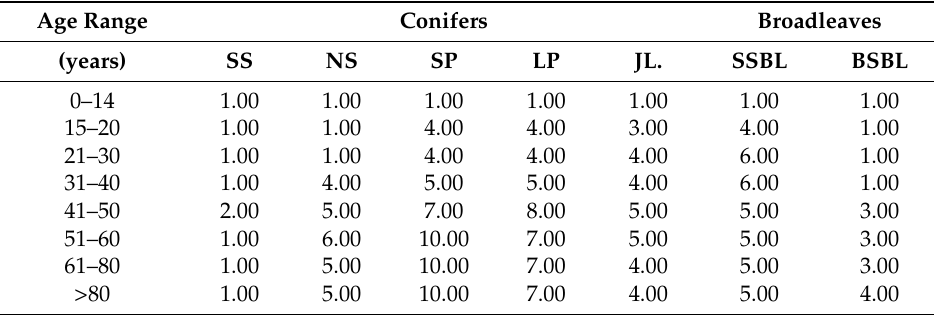
Table A8. Red squirrel habitat suitability scores, by species and age class.